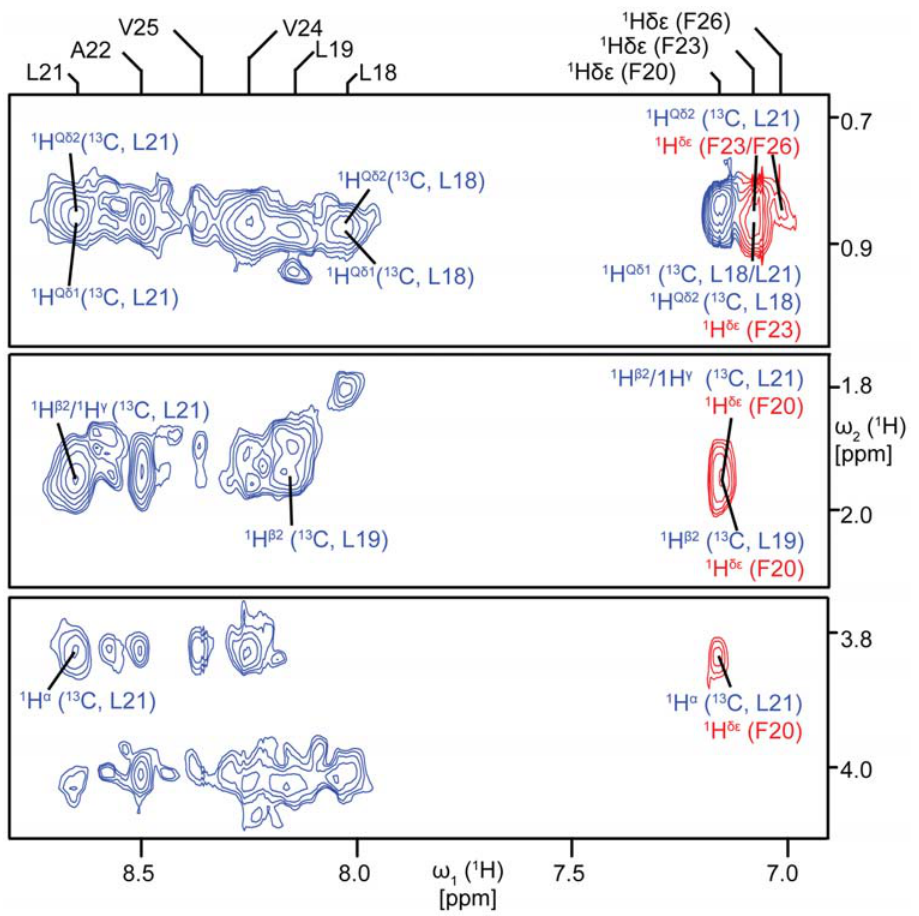
Figure 2. Intra- and inter-monomeric NOEs. Dereference 2D homonuclear 1 H N , 1 H aromatic band-selected NOESY exhibiting NOEs between 1 H covalently bound to the 13 C spins of L18, L19, and L21 and other proximal 1 H spins. Intramonomeric cross-peaks are shown in blue. Cross-peaks which cannot be explained by intramonomer interactions based on the reconstructed secondary structure are assigned to intermonomer NOEs, and are shown in